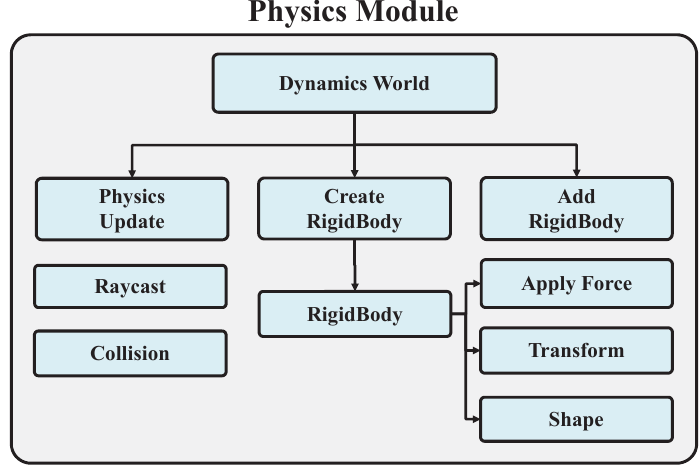
Figure 3. The physics